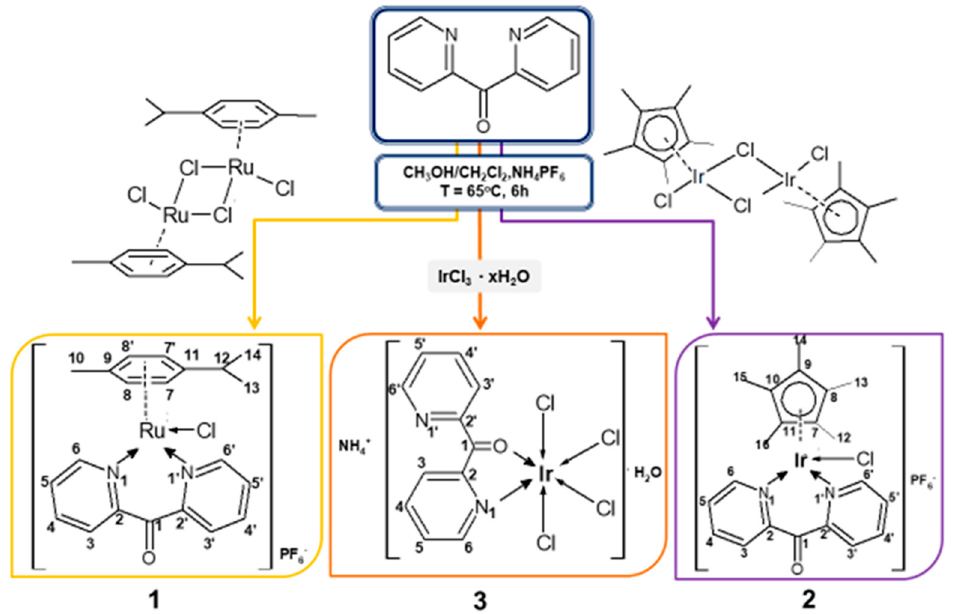
Scheme 2. Synthesis procedures for complexes 1 - 3 including the numbering of the relevant atoms for the assignment of the appropriate to NMR